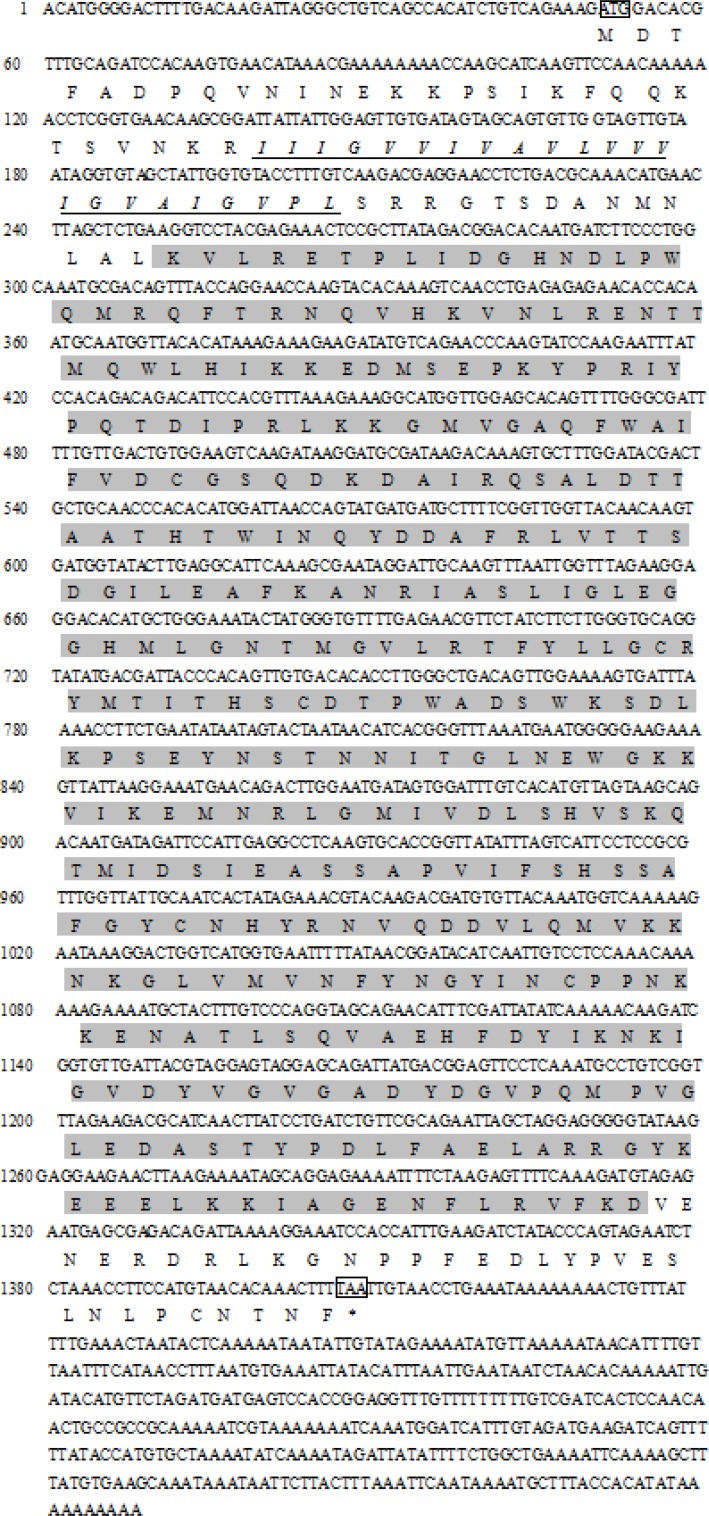
Complete cDNA sequences of DPEP1 from Tegillarca granosa and deduced amino acid sequences. The deduced amino acid sequence is shown below the nucleotide sequence in single letter code, and the predicted transmembrane region sequence is indicated with italics and underlined letters. The start and stop codons and tailing signal are framed. The shadowed part belongs to the domain of peptidase family M19.